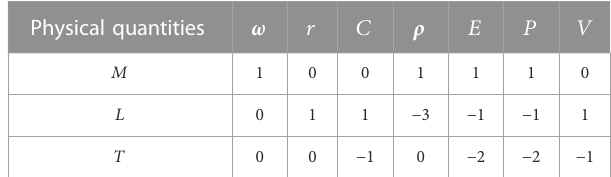
TABLE 5 Each physical quantity dimension power index.